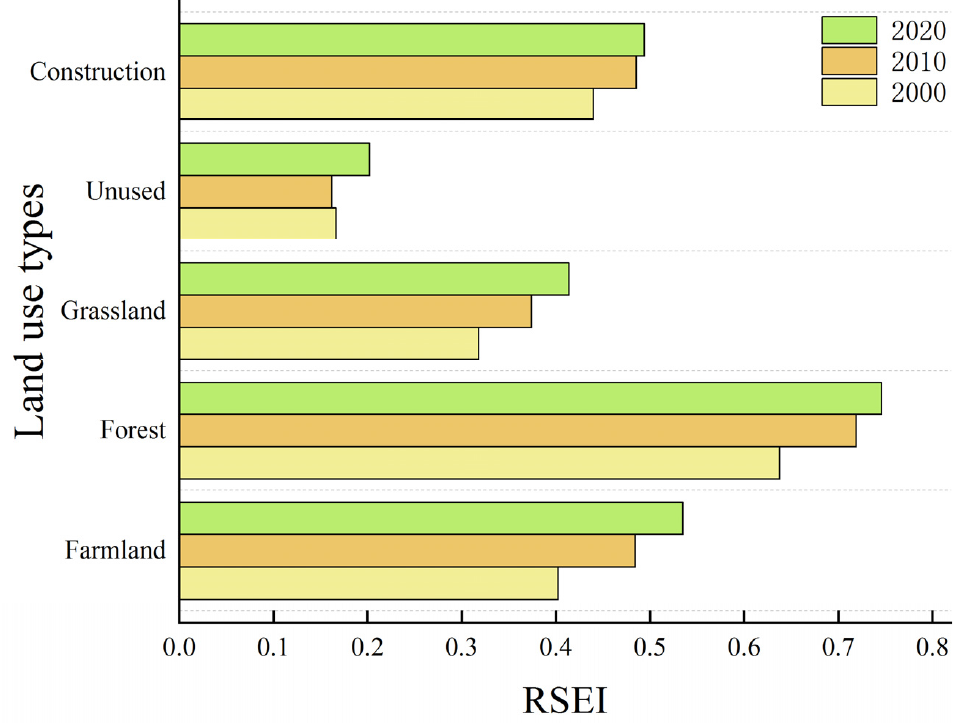
Figure 9. Mean RSEI of each land use type s.